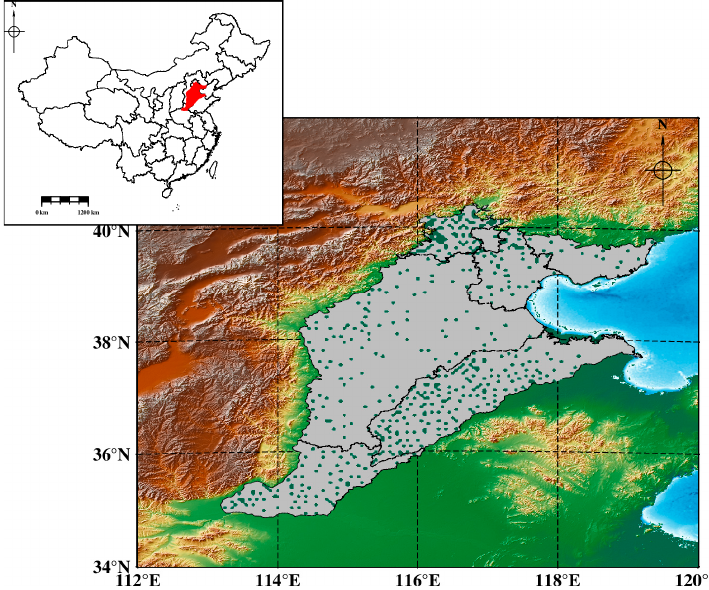
Figure 1. The observed networks of shallow groundwater levels including 556 monitoring wells are also presented.